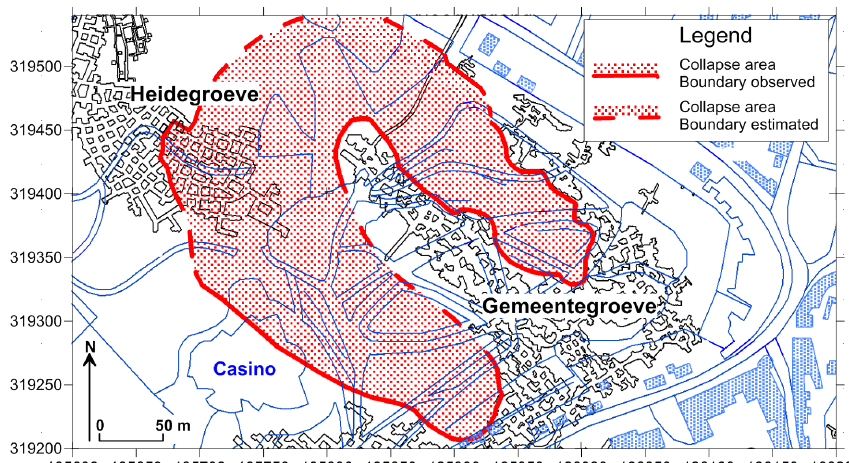
Figure 5. The collapse area between the Heidegroeve and the